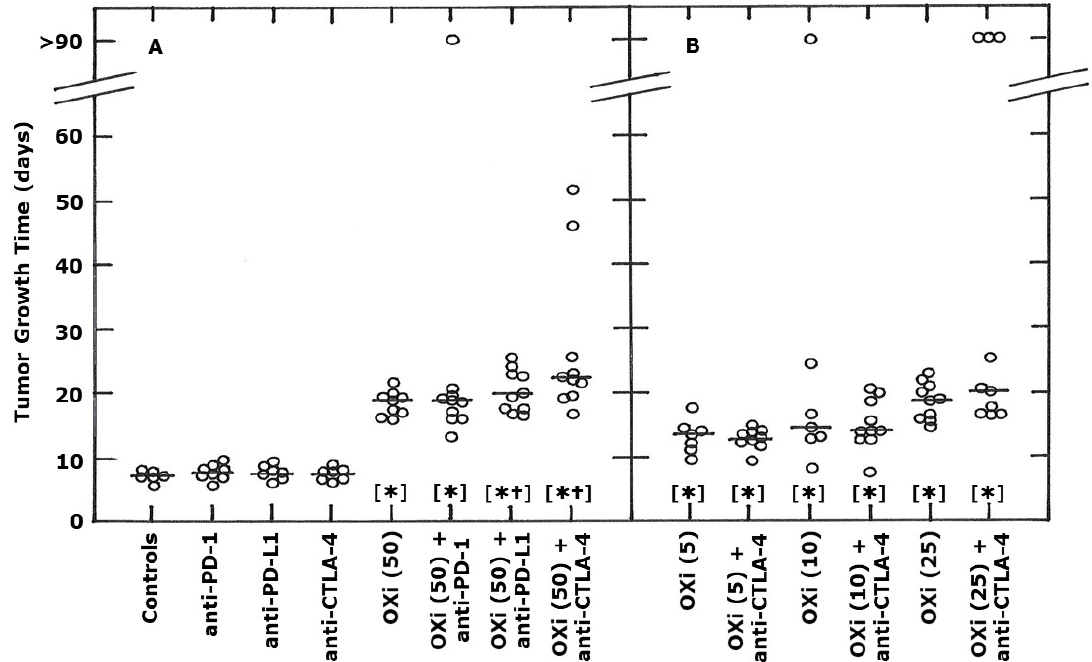
Figure 2. Effect of OXi4503 (OXi) and monoclonal antibody inhibitors (10 mg/kg) of PD-1, PD-L1, and CTLA-4 on the growth of a C3H mammary carcinoma implanted in CDF1 mice. These mice were i.p.